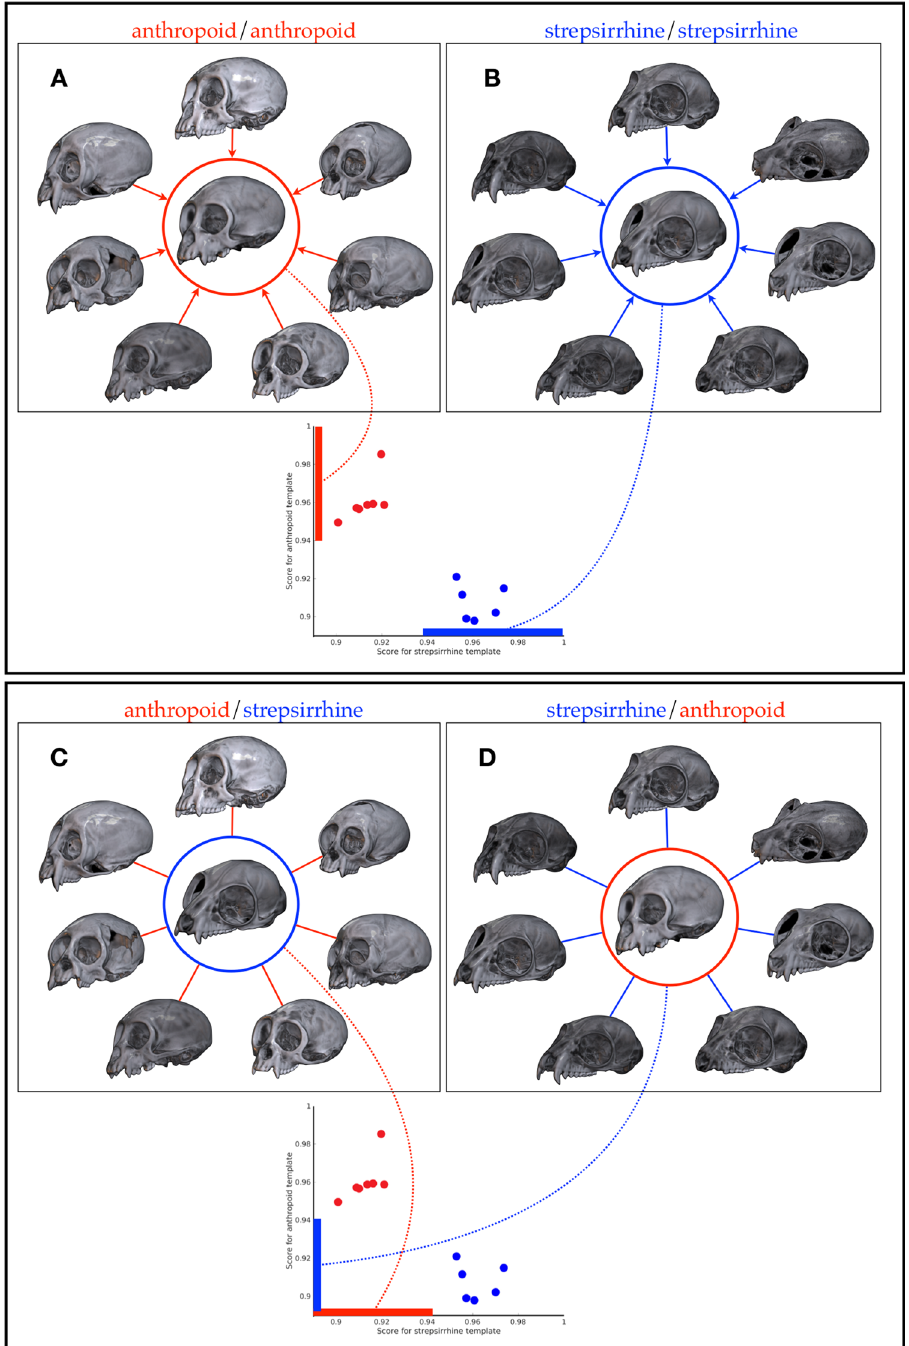
Figure 4. An example of intra-species ( A , B ) and inter-species ( C , D ) quantitative morphological comparison using CT scans of seven anthropoid and seven strepsirrhine skulls. Intra-species comparison. ( A ) Red circle encloses average anthropoid skull computed from the surrounding 7 individual skulls using SYMREG. Similarity values for individual skulls compared with the template is show as the red dot on the plot with scores on the vertical axis. ( B ) Blue circle encloses average strepsirrhine skull computed from the surrounding 7 individual skulls using SYMREG. Similarity values for individual skulls compared with the template is show as the blue dot on the plot with scores on the horizontal axis. Scores are high in all cases, as would be expected, and suggest each skull is from the same species. Variations provided by variations from the mean form a basis for quantitative comparision. Inter-species comparison. In ( C ) the average strepsirrhine from ( B ) is used for the comparison template for the seven anthropoid skulls in ( A ). The similarity values (pointed to by red dotted line) are all low, suggesting each is a poor match in species. In ( D ) the average anthropoid from ( A ) is used for the comparison template for the seven strepsirrhine skulls in ( B ). Again, the poor similarity scores (pointed to be blue dotted line) suggest that the species are different. Note that while the similarity measure here (mean squared difference) is a simple scalar values, it is derived from the volumetric differences between individual skulls and templates which can be used to identify specific locations of geometric